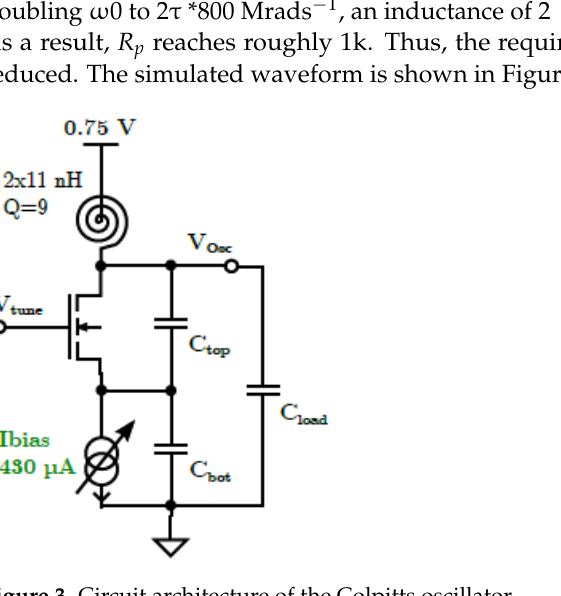
Figure 4. Simulated transient characteristic of the Colpitts oscillator. 3.3. Frequency Divider The frequency divider is necessary to obtain the desired carrier frequency of about 400MHz from the local oscillator, which operates at 800 MHz. A TSCP divider architecture shown in Figure 5 exploits the master – slave configuration presented in [21]. The master –